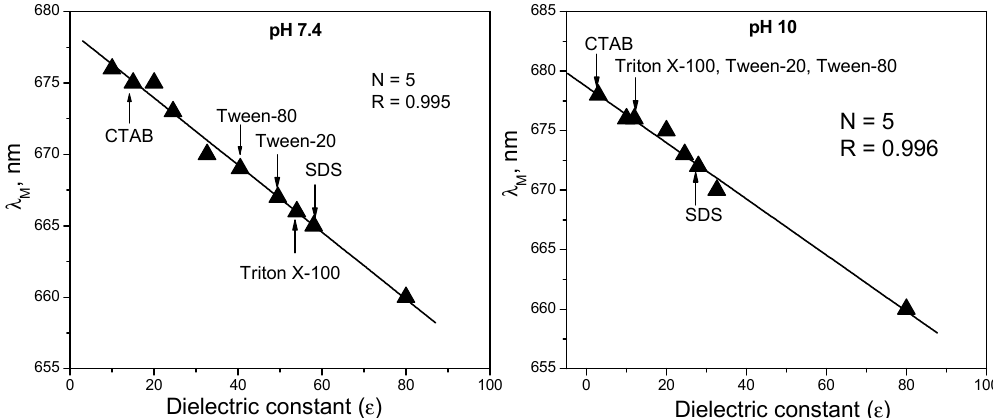
Figure 6. Absorption maxima of mitoxantrone monomer ( λ M ) in different solvents (water, methanol, ethanol, propanol, tert -butanol) as a function of the dielectric constant at pH 7.4 and 10. The positions for the surfactant micelless at pH 7.4 and 10 are shown on the graphs (the figure was drawn based on the references [41–43]).